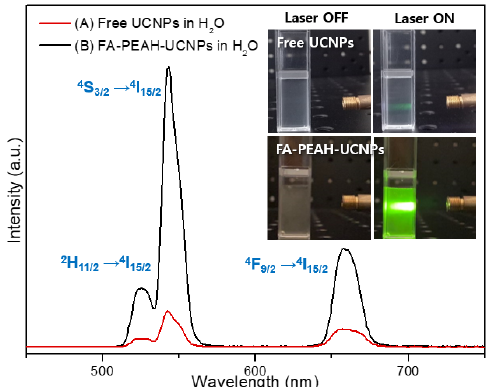
Figure 6. Fluorescence emission spectra of (A) free UCNPs (B) copolymer-modified UCNPs (FA-PEAH-UCNPs) in water under 980 nm laser excitation; inset shows the green fluorescence emission from free UCNPs and FA-PEAH-UCNPs upon 980 nm laser